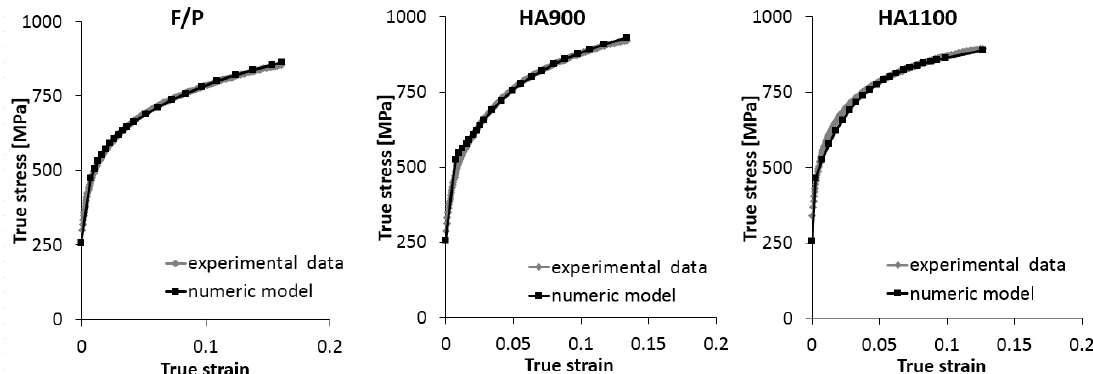
Figure 10. Comparison of true stress true strain of the whole material obtained by experimental data [28] and the numerical model for each steel.